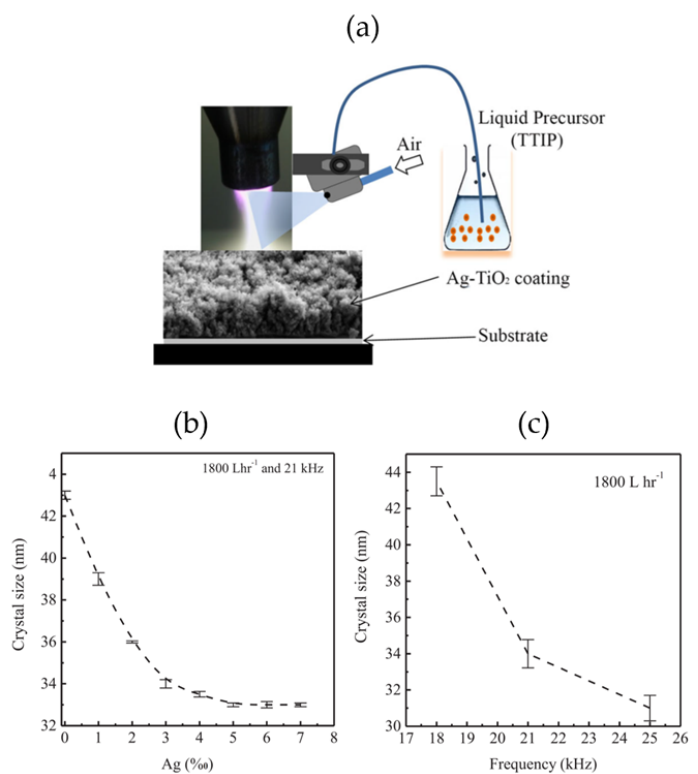
Figure 7. ( a ) Schematic of the apparatus used to deposit Ag/TiO 2 nanocomposite coating by spraying a dispersion of Ag nanoparticles in titanium tetraisopropoxide liquid precursor in the vicinity of AP plasma jet (see Figure 2d). Anatase TiO 2 crystal size in the NC coating as a function of ( b ) the Ag NPs concentration in the starting dispersion and ( c ) the discharge pulse frequency. Reproduced with permission from [83].